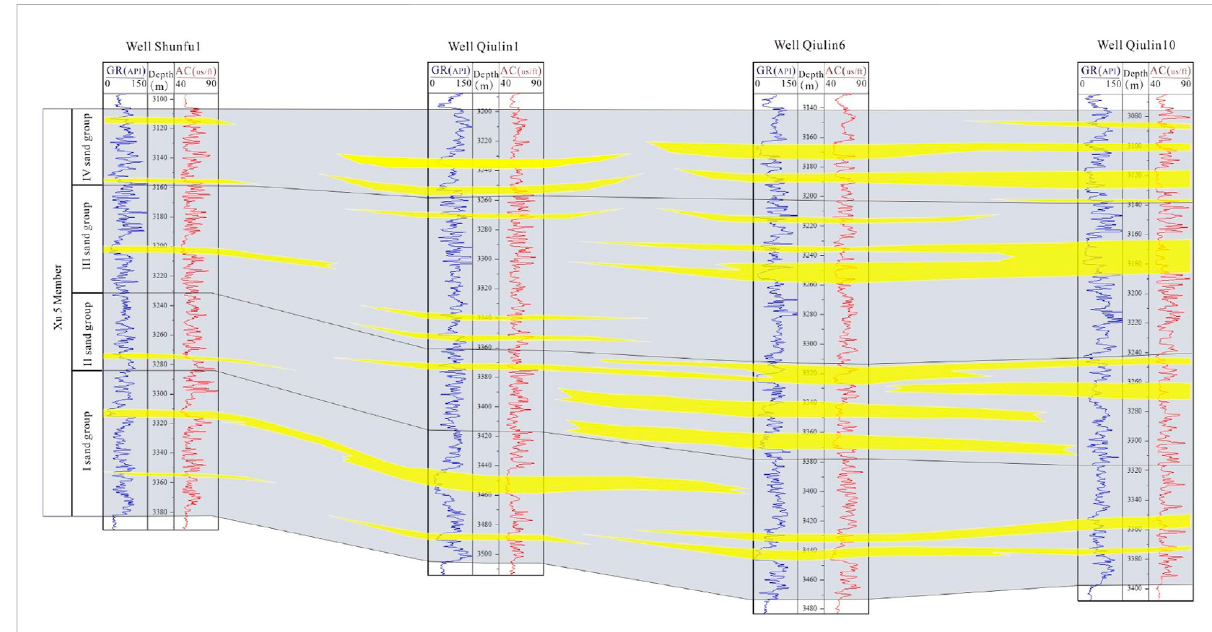
FIGURE 6 Well-connected pro fi le of the source-reservoir assemblage within the source of the Xu 5 Member (the plane position is shown in Figure 8). Yellow represents sandstone and grey represents mudstone.